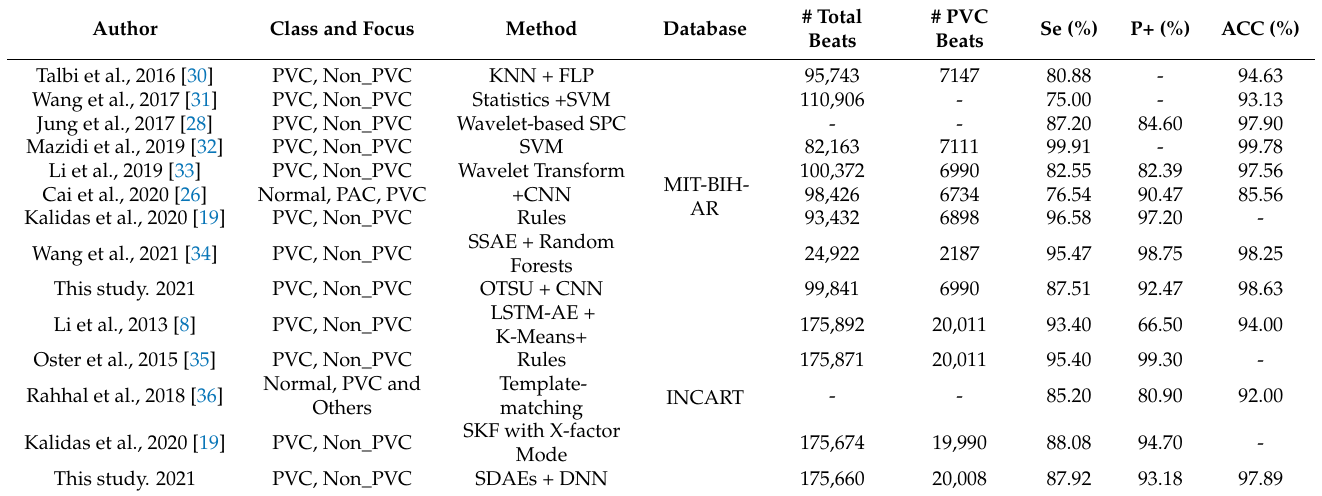
Table 4. Comparison of PVC recognition between the proposed method and existing methods on MIT-BIH-AR database and INCART